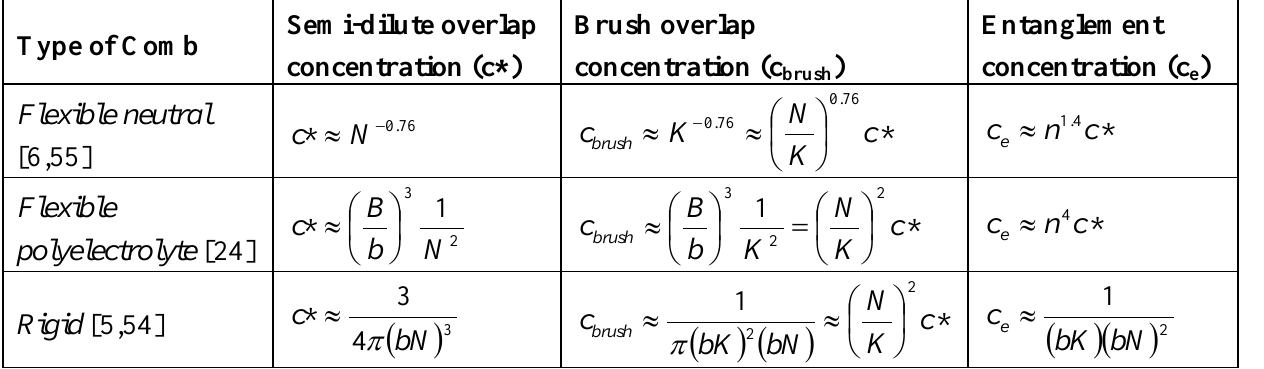
Table 2. Scaling expressions can be used to calculate the critical concentrations (in units of the number of monomers per unit volume) in comb solutions: semi-dilute overlap ) and the entanglement concentration concentration ( c *), brush overlap concentration ( c brush ( c ). n is the number of overlapping chains required for an entanglement, B is the ratio of e the contour length to the end to end length, b is the monomer length, N is the number